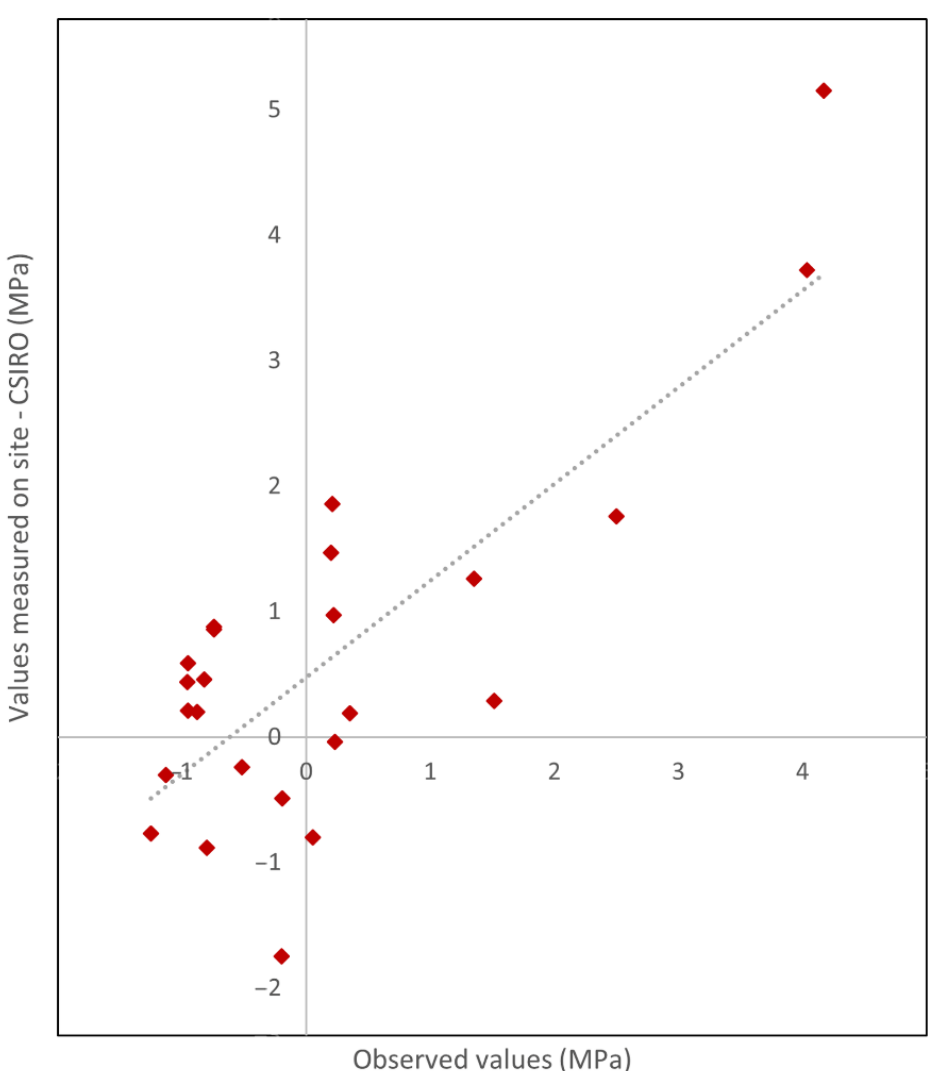
Figure 14. Correlation between the stress values observed in the CSIRO tests and those after model calibration in RS3 © .